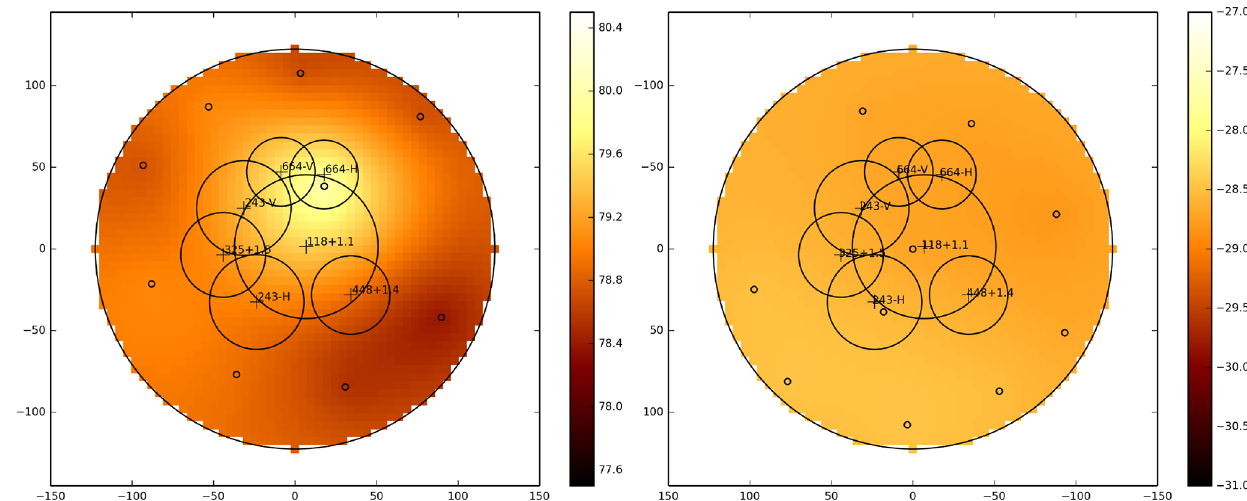
Figure 5. Hot (left) and ambient (right) calibration target temperature distribution during high-altitude flight. The small circles represent the locations of the PRTs, and the colour shows the temperature (in ◦ C) obtained by interpolating between the measurements. The − 3dB footprint of the receivers is also indicated by the larger